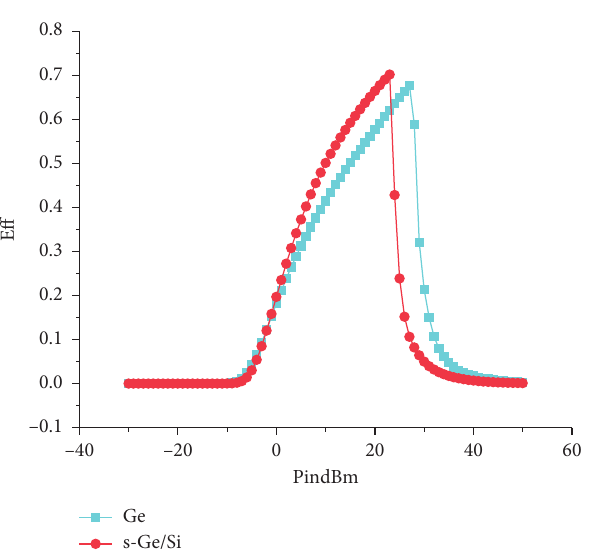
Figure 15: Conversion efficiency of s-Ge/Si Schottky diode in the rectifier